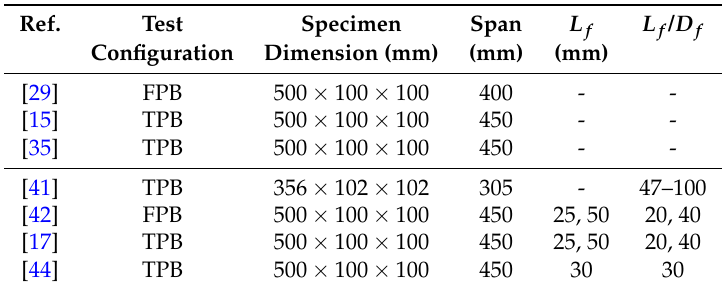
Table 1. Specimen and fiber dimensions (in mm), test configuration (TPB: three-point bending; FPB: four-point bending), used by Oh [29], Shi et al. [15] and Zhang et al. [35] for plain concrete and Johnston and Zemp [41], Singh et al. [42], Mohammadi and Kaushik [17] and Goel and Singh [44] for those reinforced with fibers.